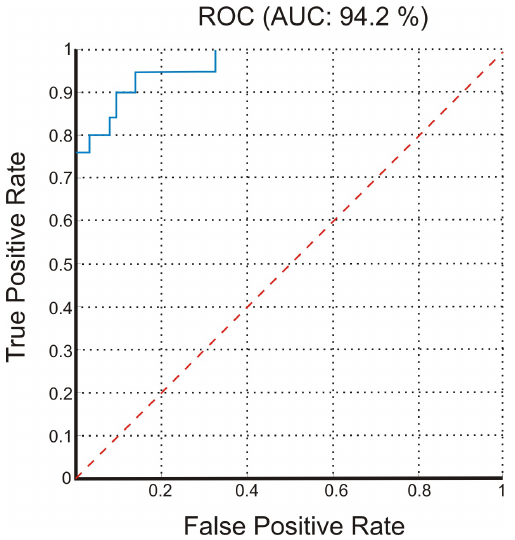
Figure 10. Receiver operating characteristic (ROC) curve analysis (blue line) for the implemented automatic analysis system for high-throughput screening of C. difficile anti-toxin compounds. AUC: area under the